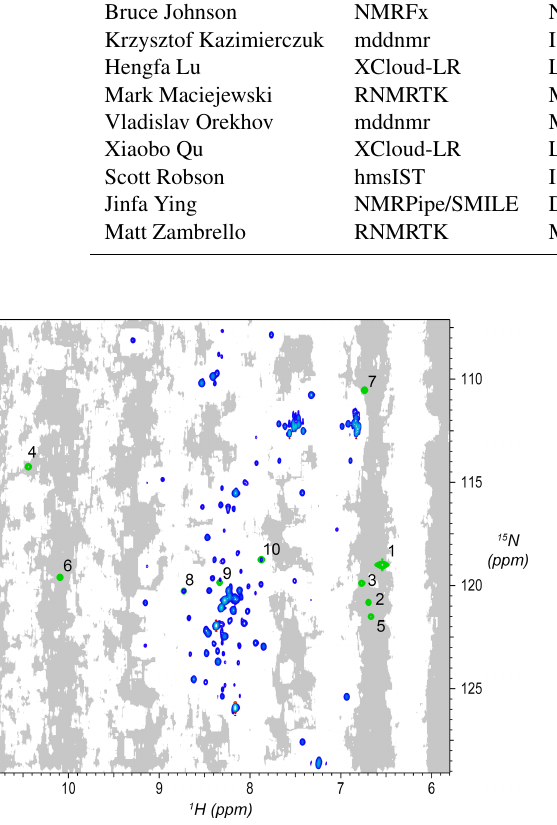
Figure 2. Synthetic peaks injected into HNCA empirical data. Two- dimensional projection of the 3D empty region mask (gray) over- layed with the 2D projections of the 3D reference spectrum (blue) and simulated signals (green). The areas shaded gray are regions in the measured data determined to be signal-free, such that a signal in- serted at any shaded position will have no substantial signals nearby anywhere in the 3D spectrum. Synthetic signals were generated by the command in Fig. 3, which generates 10 strips of synthetic peaks at the 1 H, 15 N positions labeled here. Strips from positions 7 to 10 are shown in Fig. 4. As can be seen here, strips 1 to 7 are at 2D coordinates with no existing peaks, strip 9 is at a 2D coordinate that partially overlaps with existing peaks, and strips 8 and 10 are at 2D coordinates that correspond exactly to existing